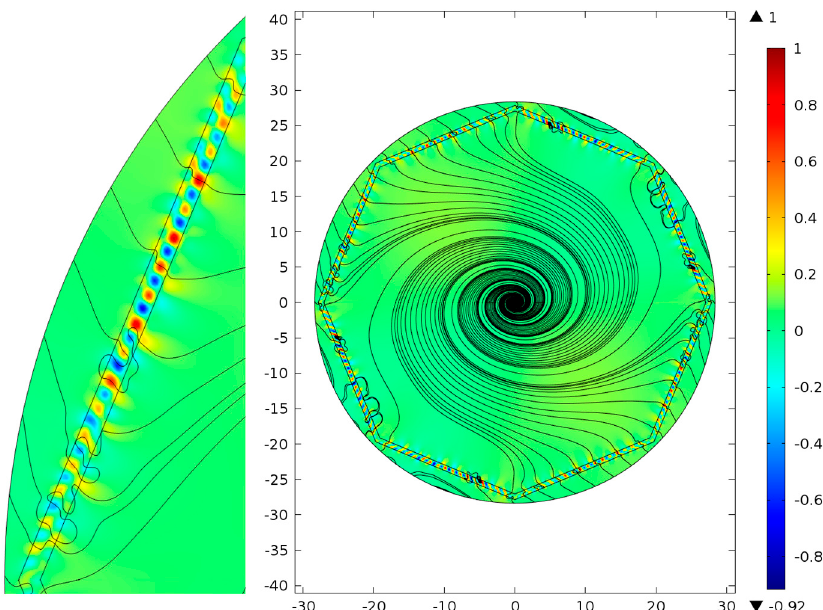
Figure 3. Distribution of the transverse Poynting vector component projection on the radius vector direction in the silica glass octagon waveguide microstructure cross section. The streamlines for the transverse component of Poynting vector (black lines).